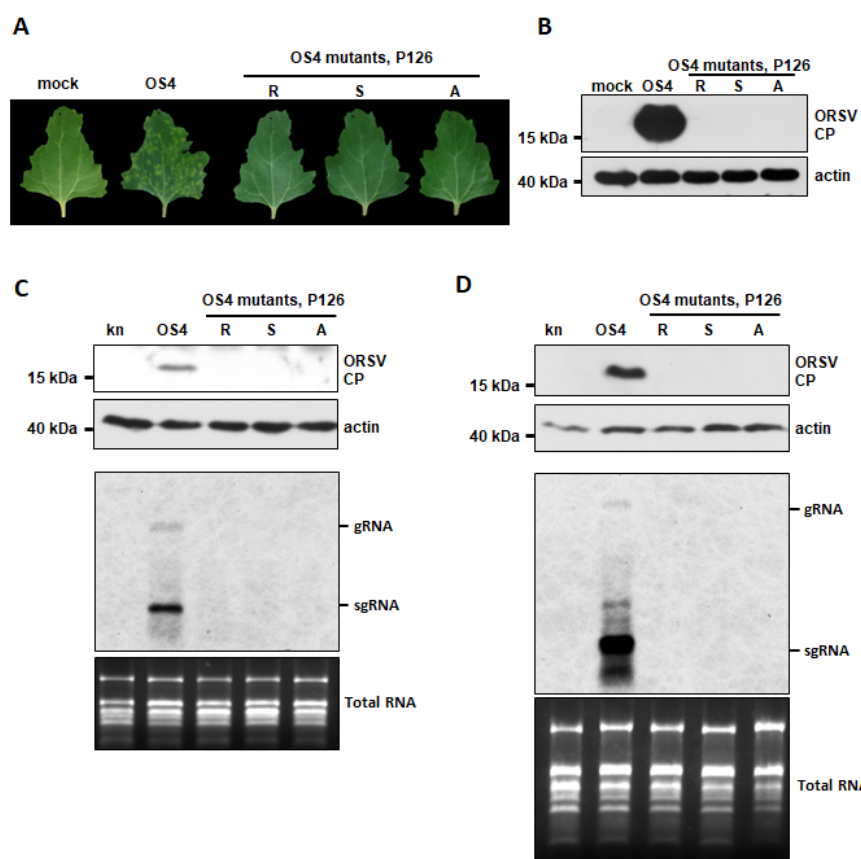
Figure 4. Replication of OS4 and its P126 mutants. ( A ) Symptoms of C. quinoa leaves inoculated with transcripts of OS4 and P126 mutants at 5 DPI. Mock represents leaves inoculated with phosphate buffer, which were used as a control. ( B ) Accumulation of ORSV CP in ( A ) as assessed by Western blot. Actin acted as a loading control. ( C , D ) Accumulations ORSV CP and viral RNAs in N. benthamiana at 2 DPA ( C ) and 8 DPA ( D ), respectively. Agrobacterium carrying pkn, pkOS4, pkOS4-P126-R, P126-S and P126-A mutants were adjusted to OD 600 = 1 and infiltrated into 17-day-old N. benthamiana leaves. Western blot detection of ORSV CP (upper two panels) and RNA blot for ORSV RNAs (lower two panels) were performed as described in Figure 1. Total RNA was used as RNA loading